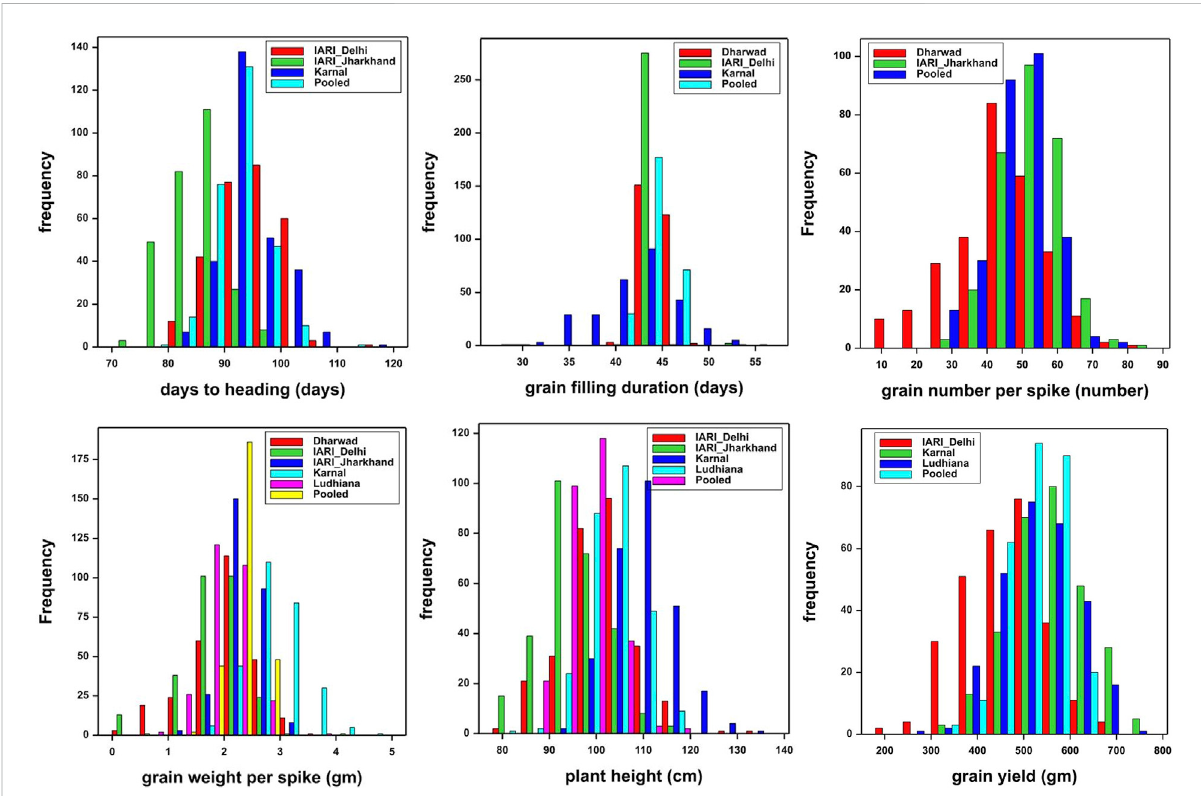
FIGURE 2 Frequency distribution of grain yield and component traits in GWAS panel evaluated at Dharwad, IARI Delhi, IARI Jharkhand, Karnal, and Ludhiana during 2020 –